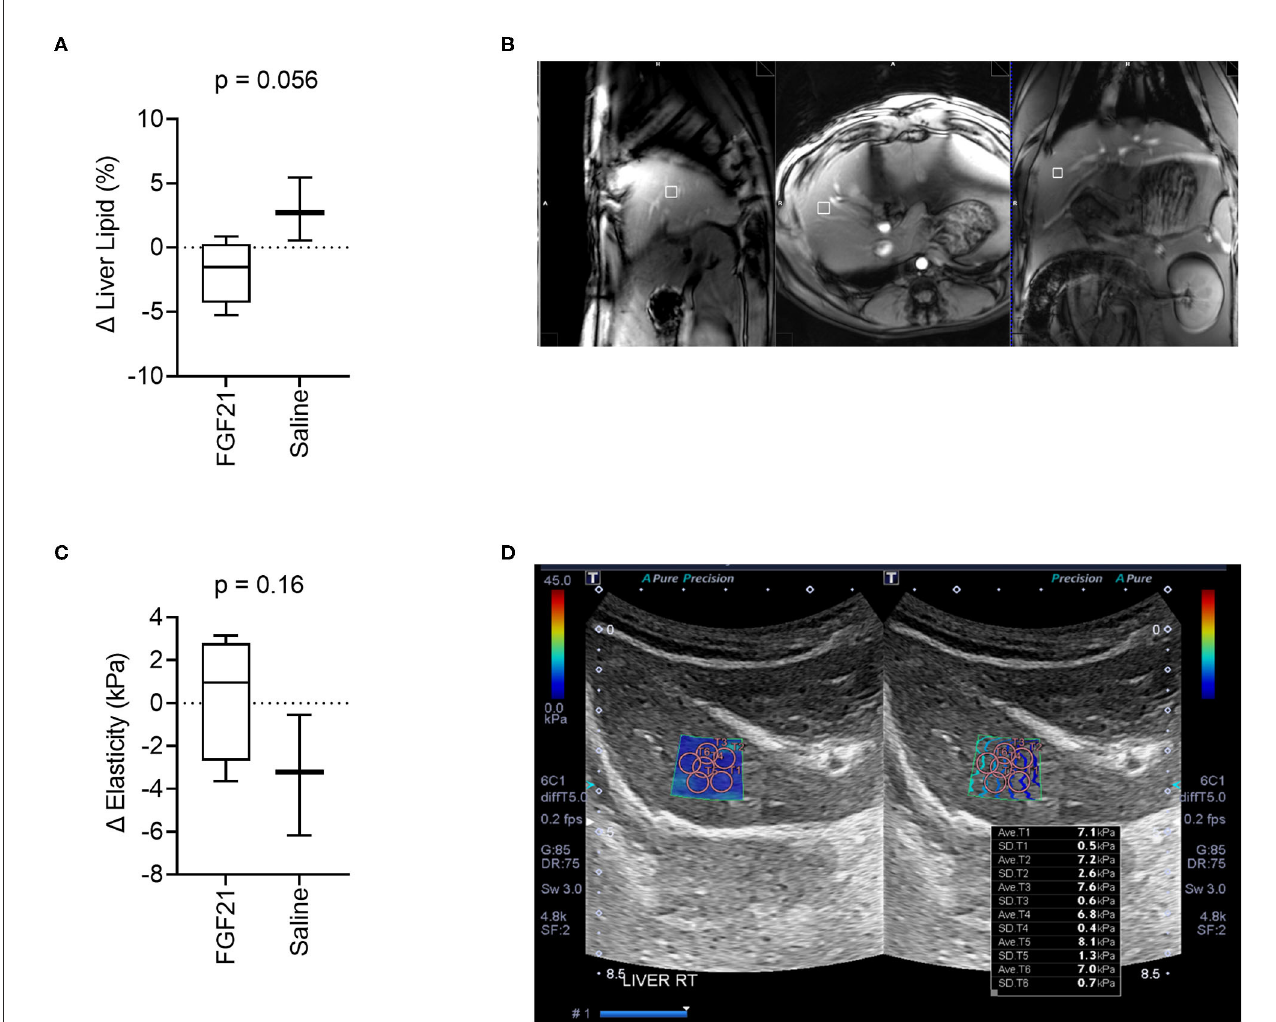
FIGURE3 FGF21 tends to protect from liver lipid accumulation but does not alter liver tissue stiffness. (A) The fraction liver lipid measured by 1H-MRS is not significantly altered by FGF21 but tends to decrease compared to lipid alterations from saline treatment (unpaired t -test). (B) Example of voxel selection for 1H-MRS from a control cat. The white box delineates the voxel region . (C) Liver tissue stiffness is not altered by FGF21 treatment (unpaired t -test). (D) Example of measurements of stiffness using elastography of a single hepatic lobe from a saline-treated